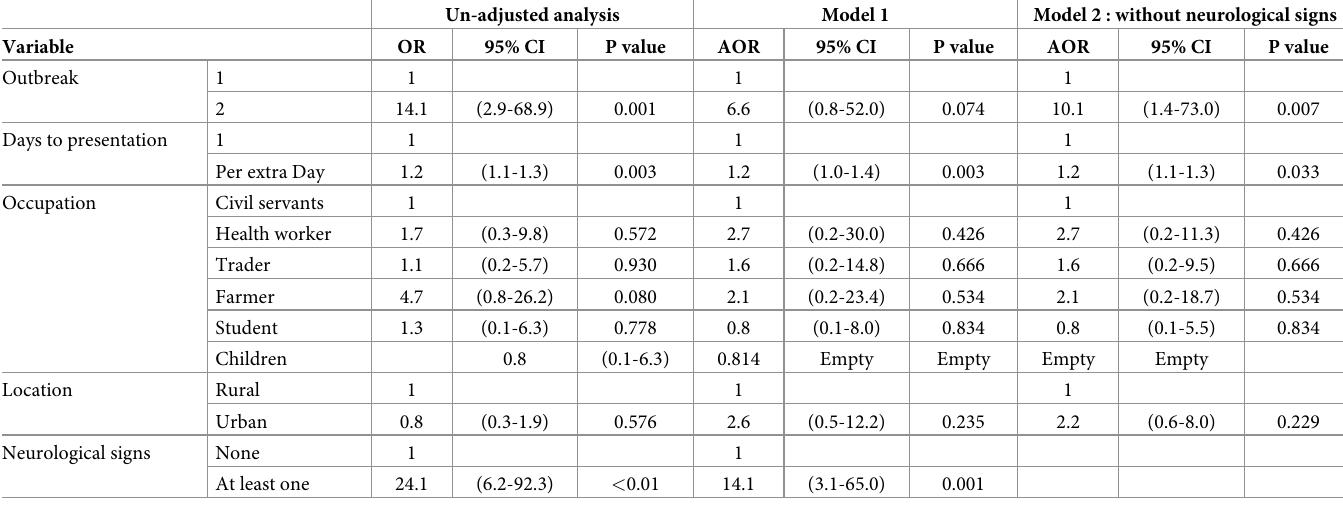
Table 4. Logistic regression showing odds and adjusted odds for mortality for selected variables in the two outbreaks. Un-adjusted analysis Model 1 Model 2 : without neurological signs